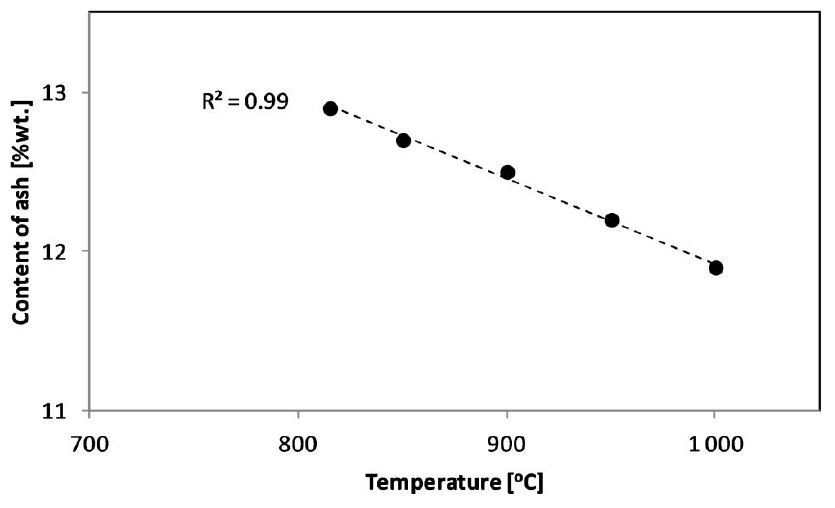
Figure 1. Variation in ash content of poultry manure (sample R1) according to combustion tempera- ture (muffle furnace).